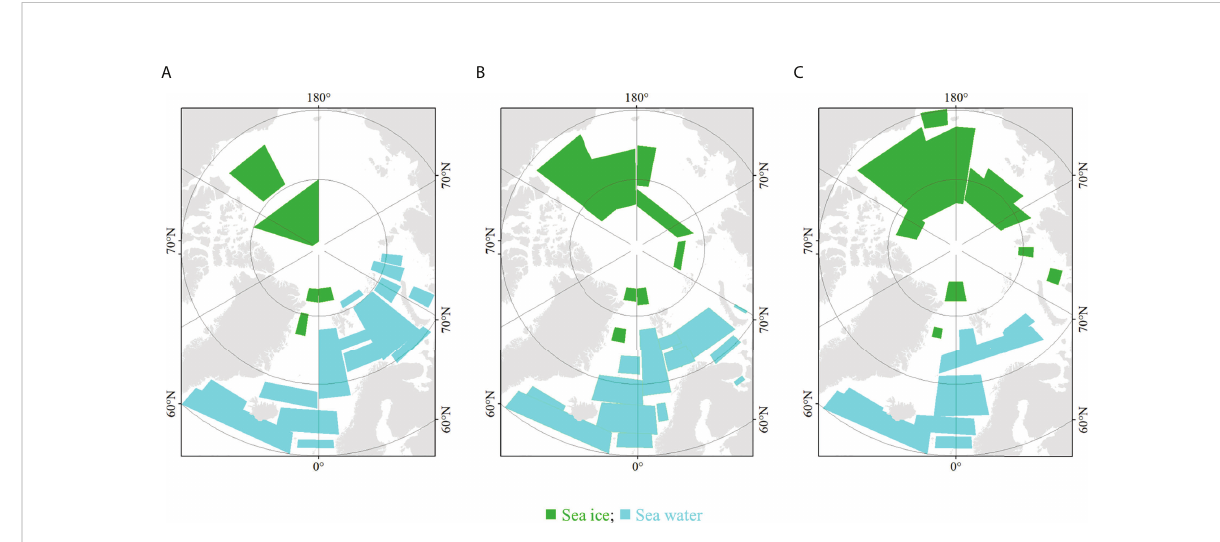
FIGURE 7 Invariant regions of the sea ice distribution at each stage: (A) Stage 1; (B) Stage 2; (C) Stage